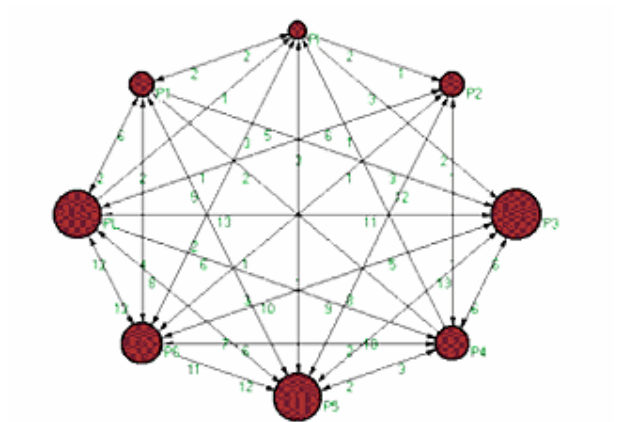
Figure 21. Directed network of hubs in the purple